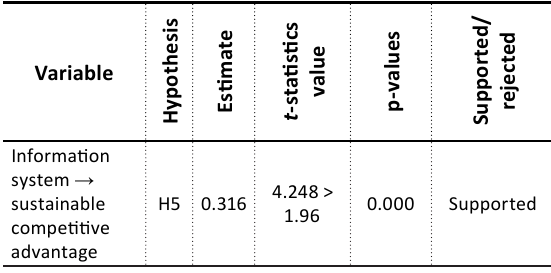
Table 5. Path coefficient for information system and sustainable competitive advantage